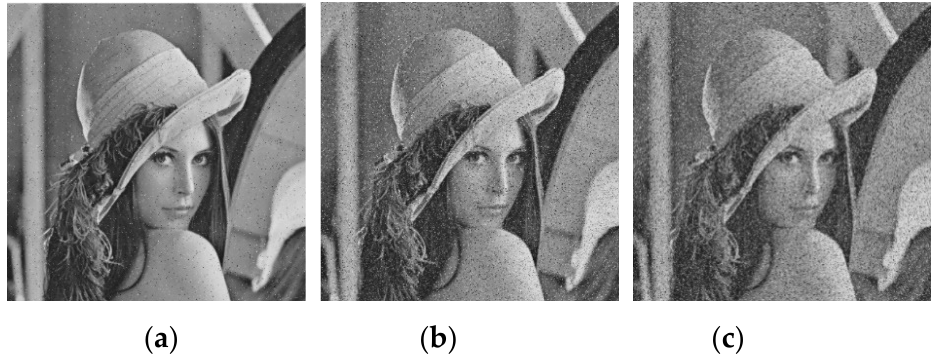
Figure 21. The results of noise attack analysis: ( a ) Noise with 2% of intensity; ( b ) Noise with 10% of intensity; ( c ) Noise with 20% of intensity.